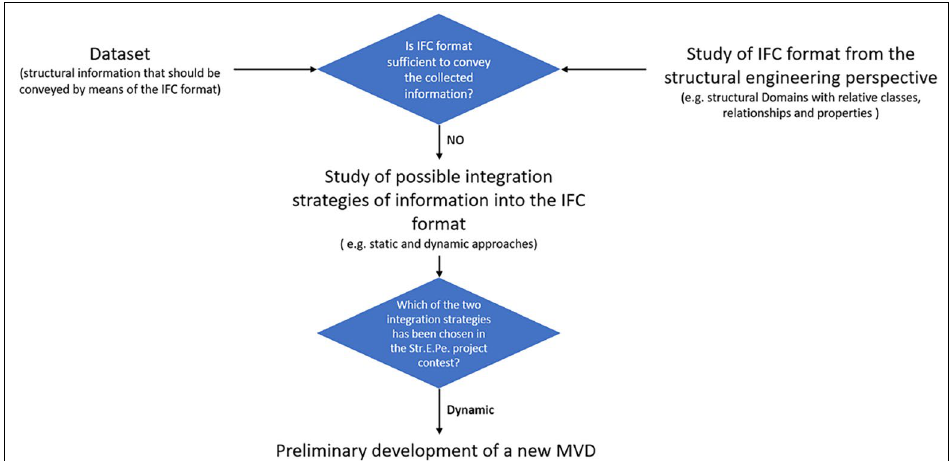
Figure 2. The reference approach of phase